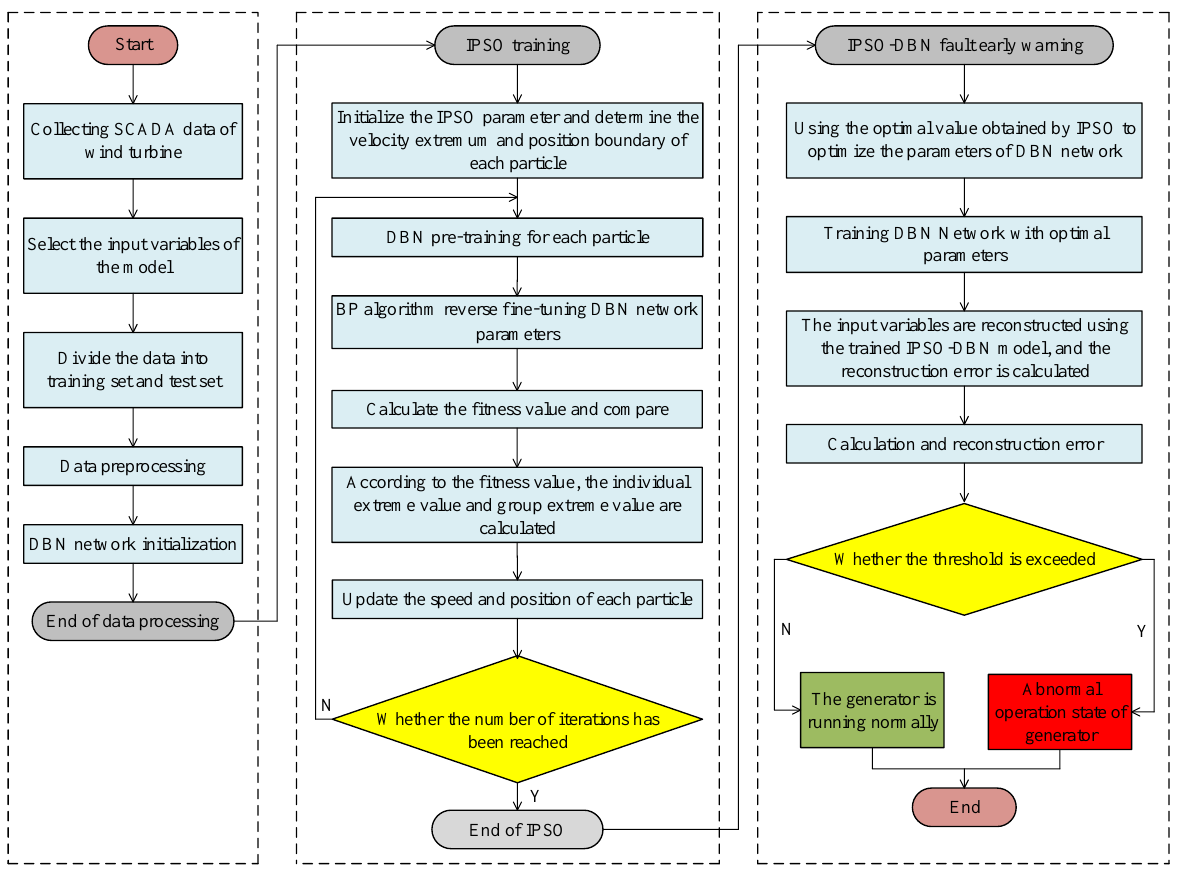
Figure 4. Forecasting results between before and after rough set correction.